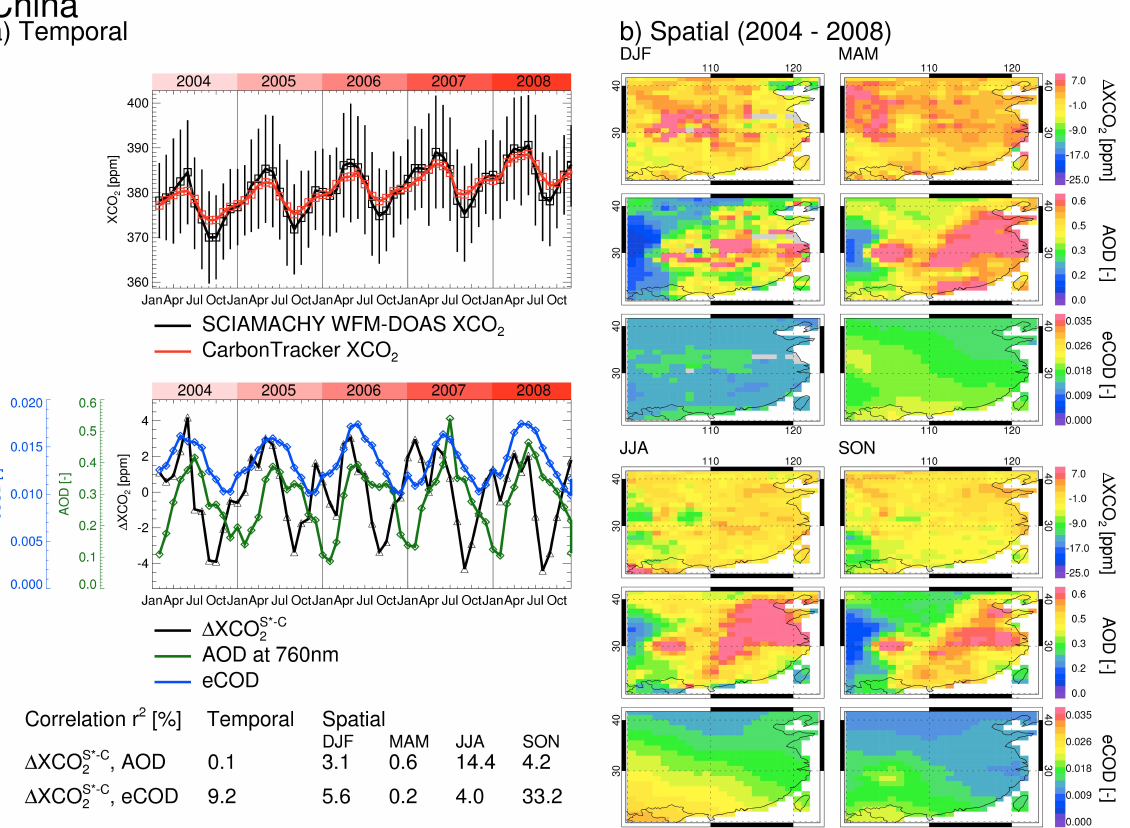
Fig. 11. Results of the temporal and spatial correlation analysis of the difference between scan-angle-corrected SCIAMACHY and Car- ∗ − C bonTracker XCO 2 , i.e. 1 XCO S , with aerosols and thin clouds for China. (a) Temporal analysis part: Top: The monthly means and 2 intra-monthly standard deviations of the WFMDv2.1 XCO 2 are shown in black and CarbonTracker XCO 2 is shown in red. Middle panel: ∗ − C 1 XCO S (black) compared with GEMS-derived AOD at 760nm (green) and CALIPSO-derived eCOD (blue). Bottom left panel: The 2 squares of the linear correlation coefficients, r 2 , of the temporal and spatial correlation analysis. (b) Spatial analysis part: Five-year seasonal ∗ − C averages of 1 XCO S , AOD and 2